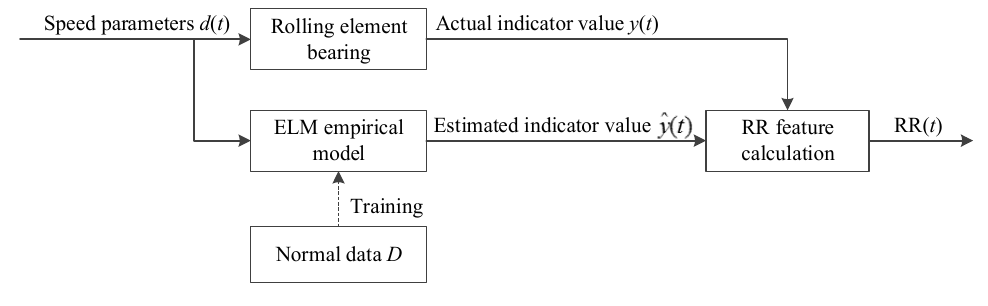
Figure 5. Schematic of RR feature extraction.